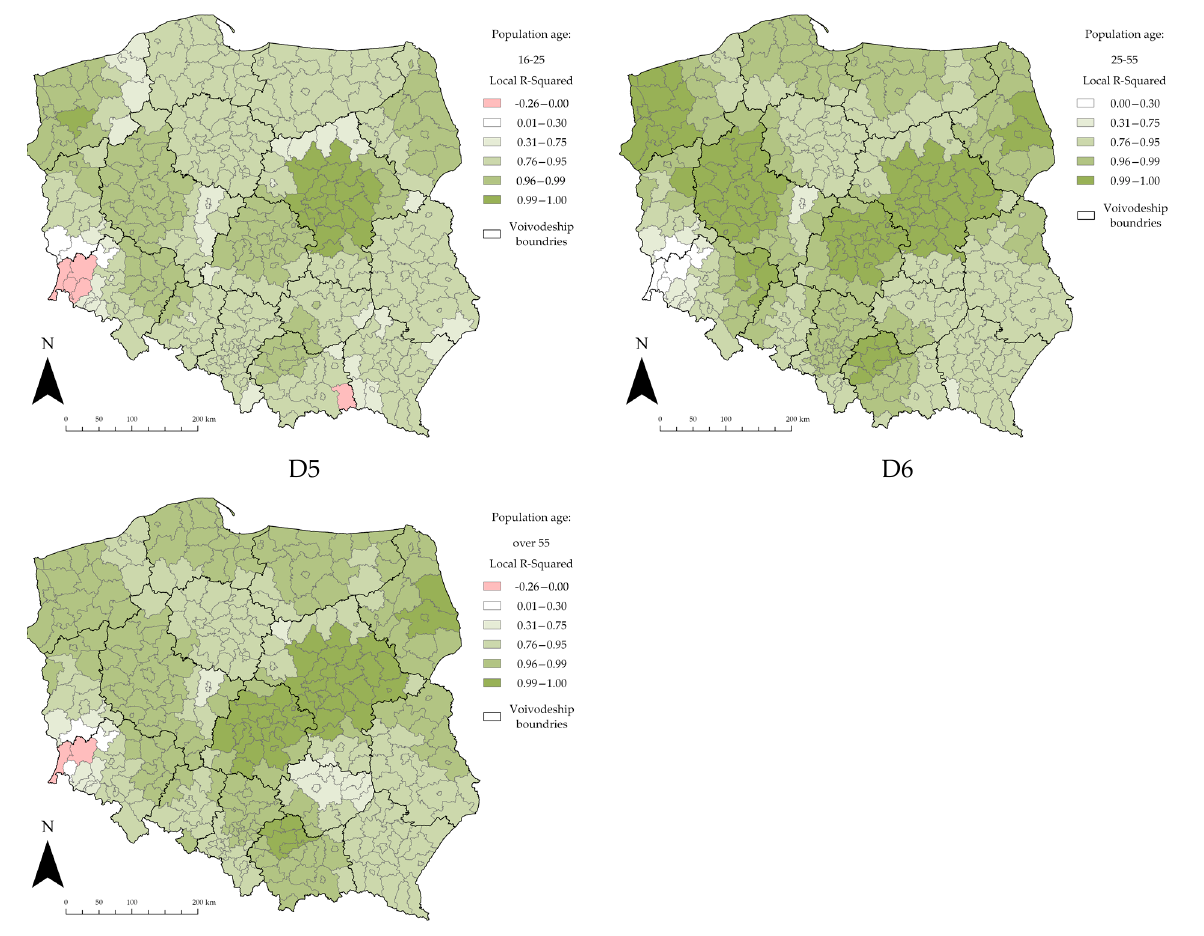
Figure 5. Local R 2 estimates for the “Demographic” section. Source: own elaboration using ArcGIS Pro 2.9 by Esri.